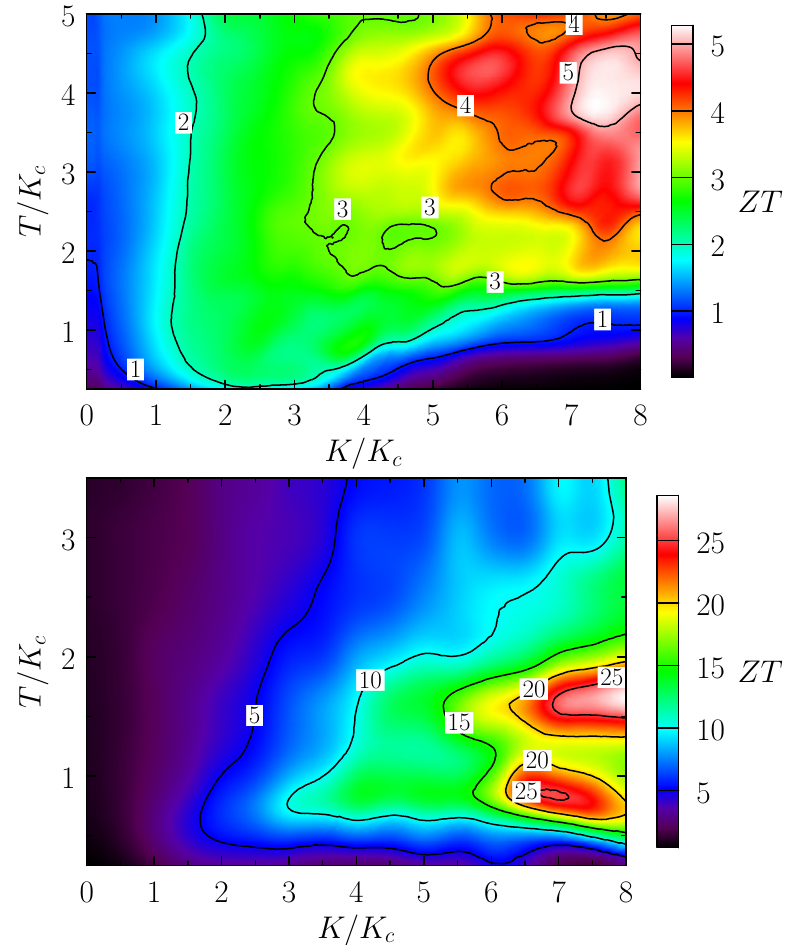
Figure 5. Color map of the figure of merit ZT values for density ν = N / L = 34/21 ( top panel) and ν = N / L = 55/21 2.618 ( bottom panel); numbers mark isocontour values of ZT . ≈ Here, K c = 0.019 for ν = 34/21 and K c = 0.14 for ν =